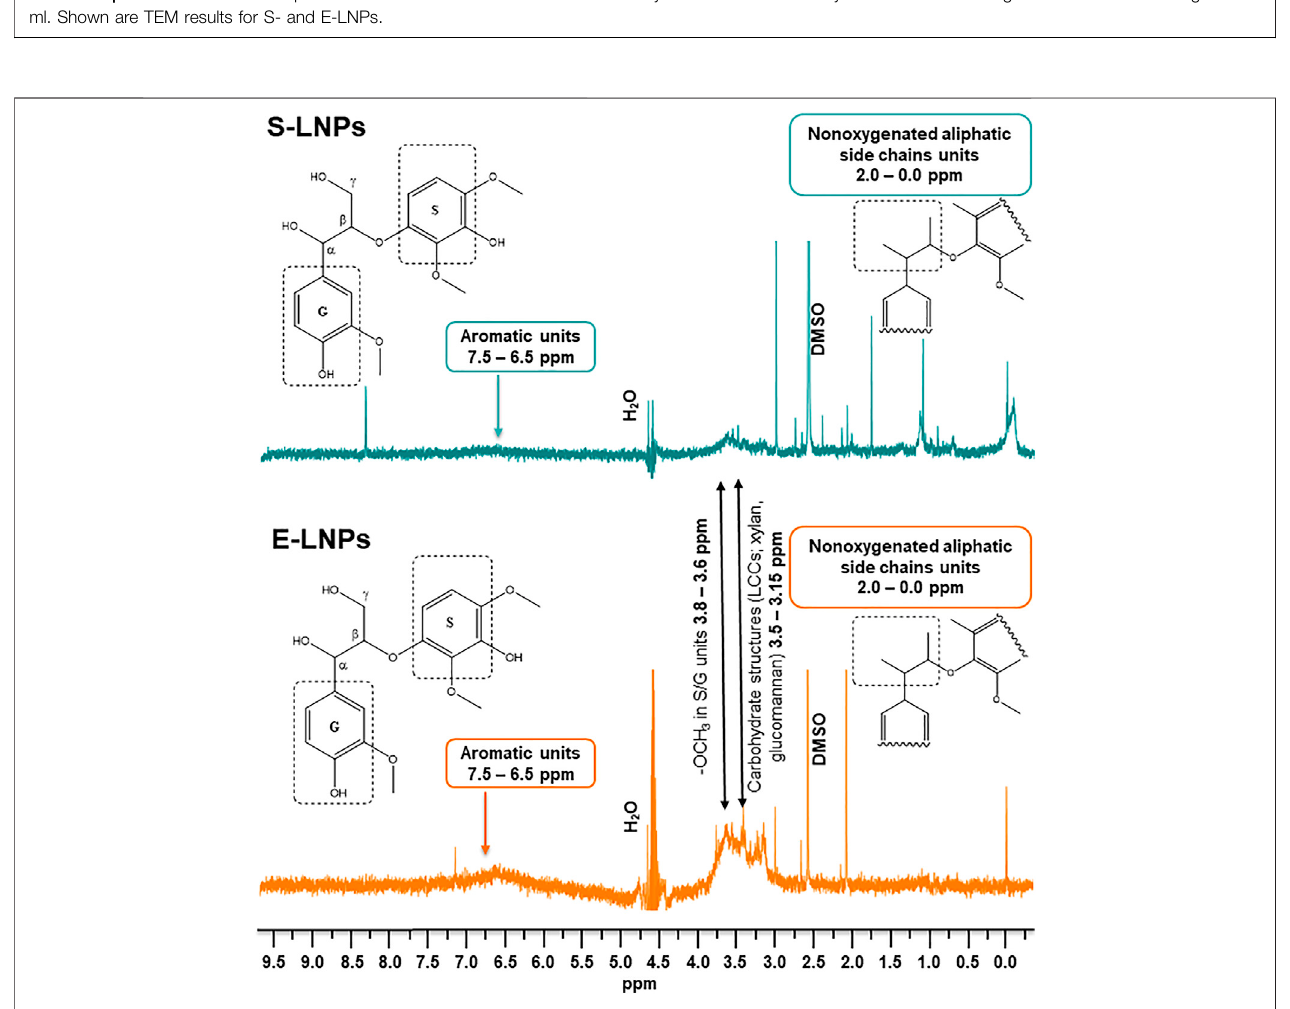
Frontiers in Bioengineering and Biotechnology |